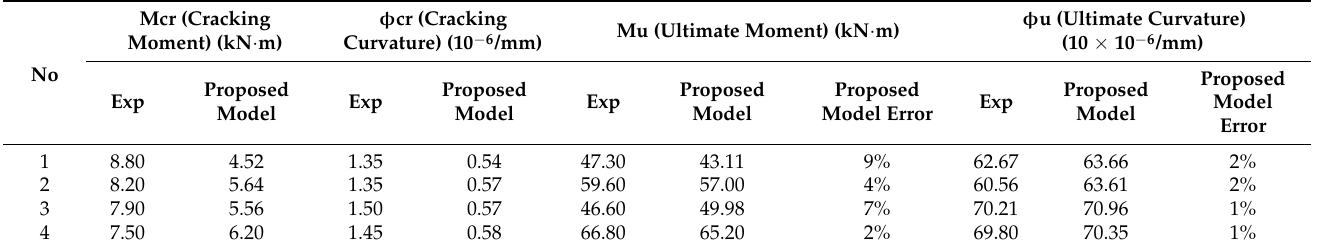
Table 3. Accuracy comparison of present model with experimental data for moment and curva- ture